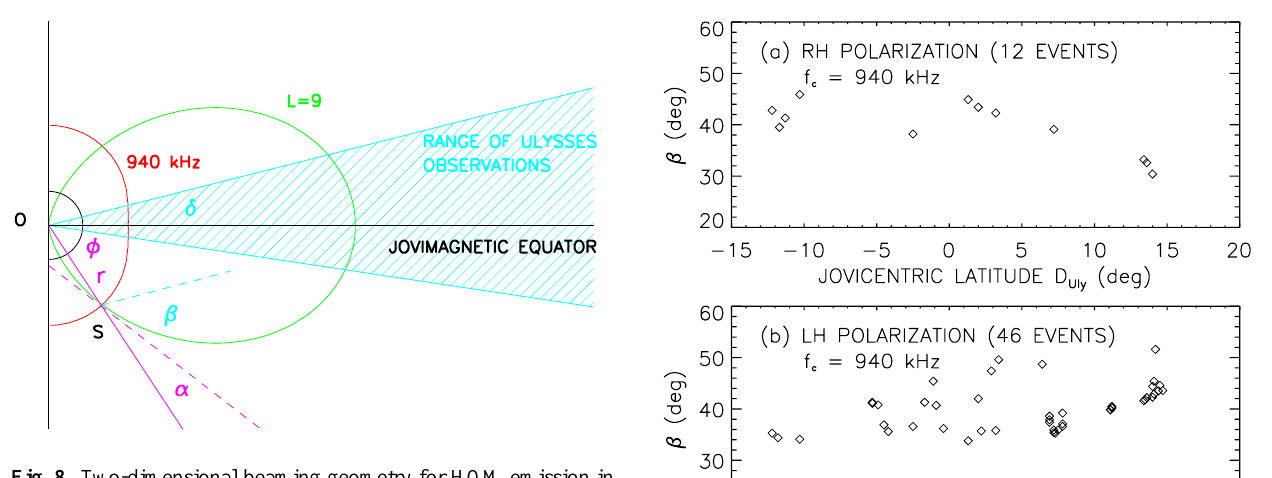
Fig. 8. Two-dimensional beaming geometry for HOM emission in a dipole magnetic field from a source on L-shell ’ 9 close to the f c = 940kHz surface. The shaded area represents the emission beam of the HOM within the jovimagnetic latitudes − 8 . 5 ◦ and 14 . 2 ◦ where the HOM was observed.